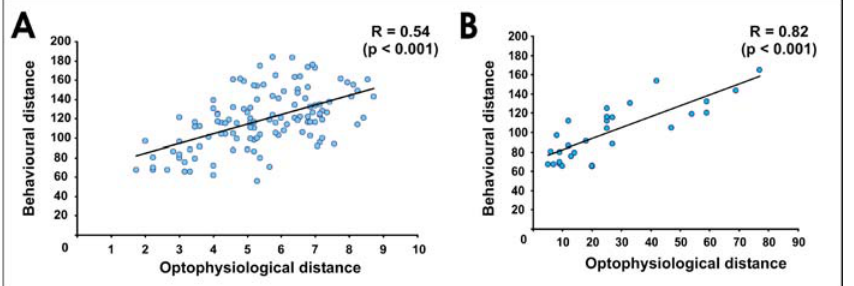
Figure 7. Correspondence between Perceptual and Physiological Odour Similarity (A) Correlation between optophysiological measures of odour similarity (carried out using calcium imaging recordings [23]) and our behavioural measures of odour similarity. Euclidian distance between odour representations in our 16-dimension ‘‘ behavioural ’’ space for all odour pairs (120 pairs, x axes) and distances between odours in optical imaging experiments, using the odour category maps displayed by Sachse et al. [23] (also 120 pairs, y axes) were calculated. This correlation, including all 120 odour pairs, was highly significant ( r = 0.54, p , 0.001). Odours found to be similar in the optical imaging study were also similar in the behaviour. Data points cluster quite broadly around the main trend line, showing that many exceptions were found. (B) Correlation between measures of optophysiological similarity carried out using the optical imaging technique [23] and our behavioural measure of odour similarity. Using the exact data given for primary and secondary alcohols [23], a much better correlation between the two datasets was achieved than in (A) ( r = 0.82, p , 0.001), although outliers were still found in the data. DOI: